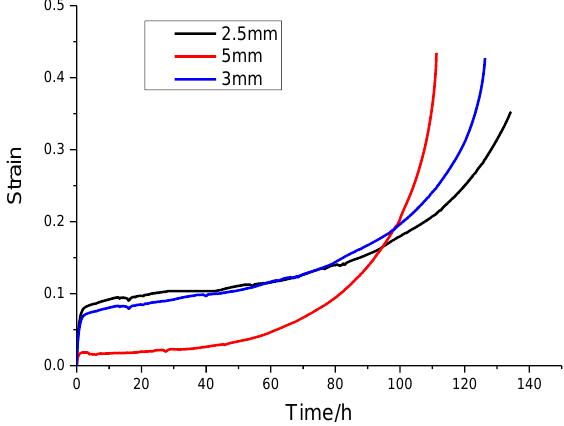
Figure 4. Creep curves of three differently sized specimens at 980 °C/300 MPa. The creep strain rate increased monotonically, with strain increasing to a maximum value of 35.2%, at which point the specimen showed damage failure. By analyzing the creep curve for a diameter of 3 mm, it was found that the behavior was still in agreement with standard creep characteristics. The same short deceleration creep stage was observed, quickly followed by the stable second stage. This second stage involved ~115 h of slow, uniform growth, accounting for 90% of the total creep time. In the very short third stage, the creep strain rate was found to change dramatically in a sharp upward trend and finally increased to 42.7% at the point of fracture. Analysis of the 5-mm creep curve diameter shows that the creep strain in the first 5 mm of the third stage is significantly smaller